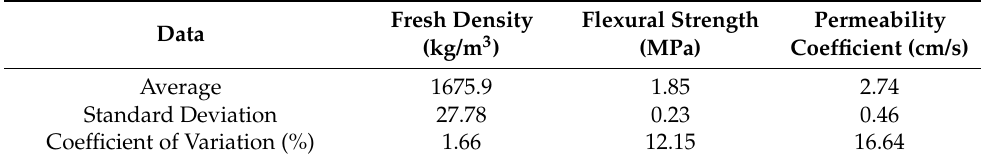
Table 11. Results of fresh density, flexural strength, and permeability coefficient obtained in the pilot-scale case